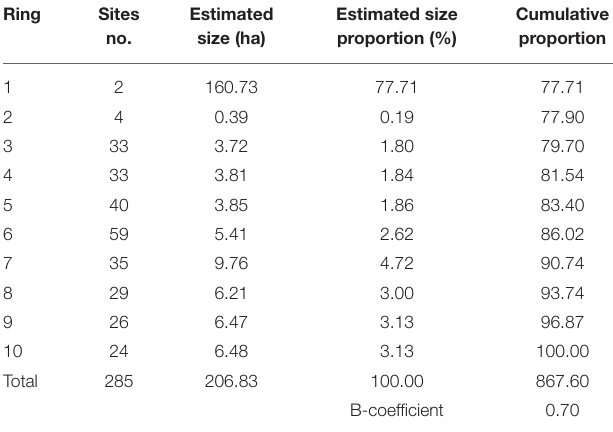
TABLE 7 | Calculation of B-coefficient for Cerveteri in the Archaic period. Ring Sites Estimated Estimated size no. size (ha) proportion (%)